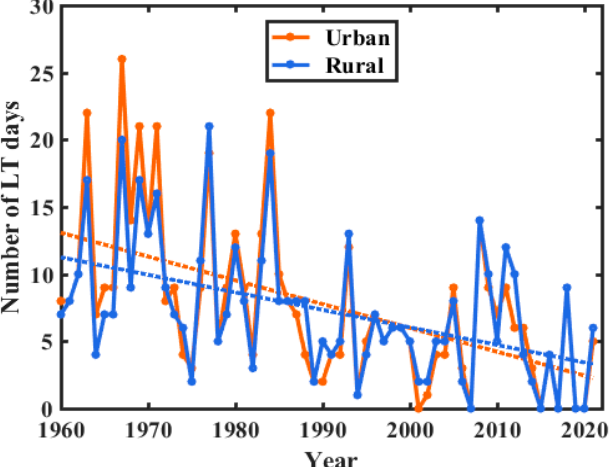
Figure 6. Changes and trends in urban low temperature (LT) days (orange) and rural LT days (blue) from 1960 to 2021.